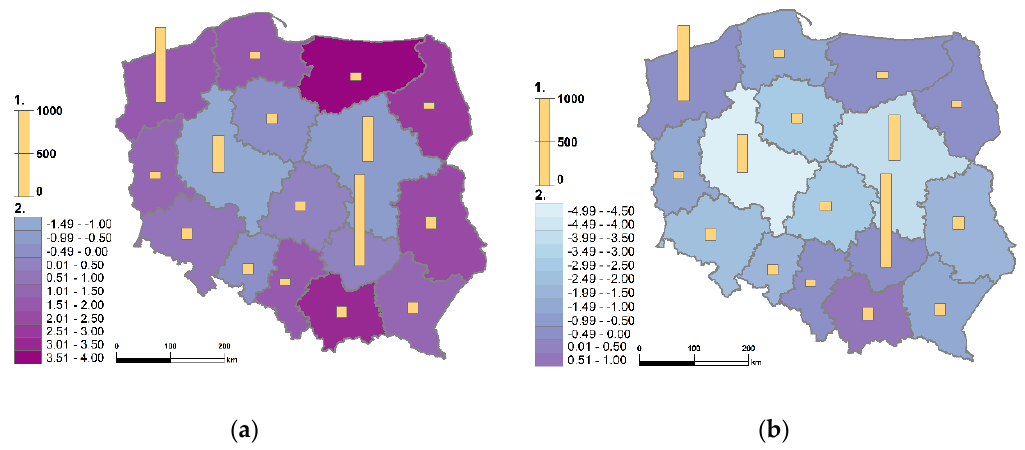
Figure 12. Water deficit map of Poland for 2015: ( a ) for 380 mm evaporation and ( b ) for 550 mm evaporation. Notes: Water consumption in m 3 / person, 2—water deficit in km 3